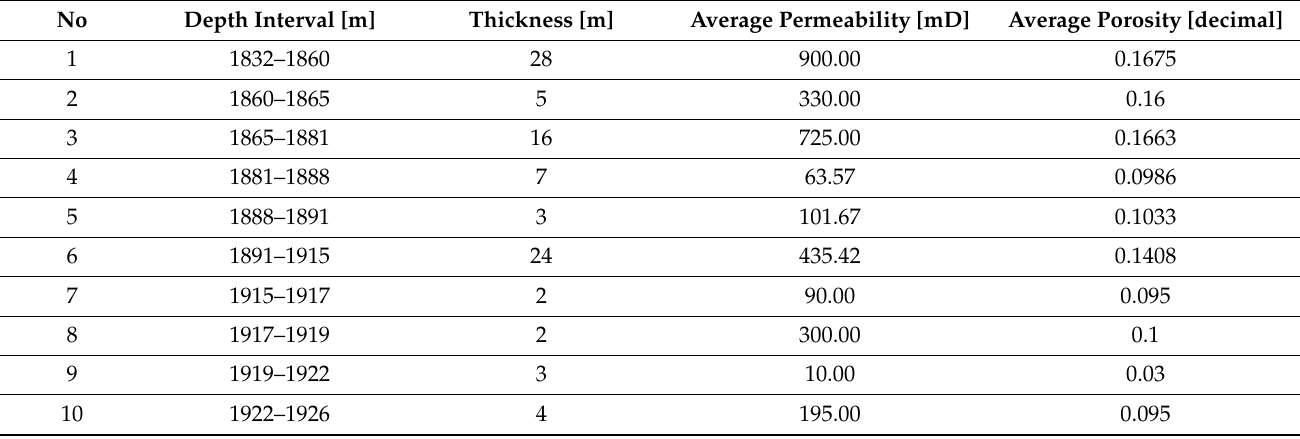
Table 2. Characteristics of the ten separate reservoir layers within the Komorowo Lower Jurassic Formation of the Konary structure in the Byczyna 1